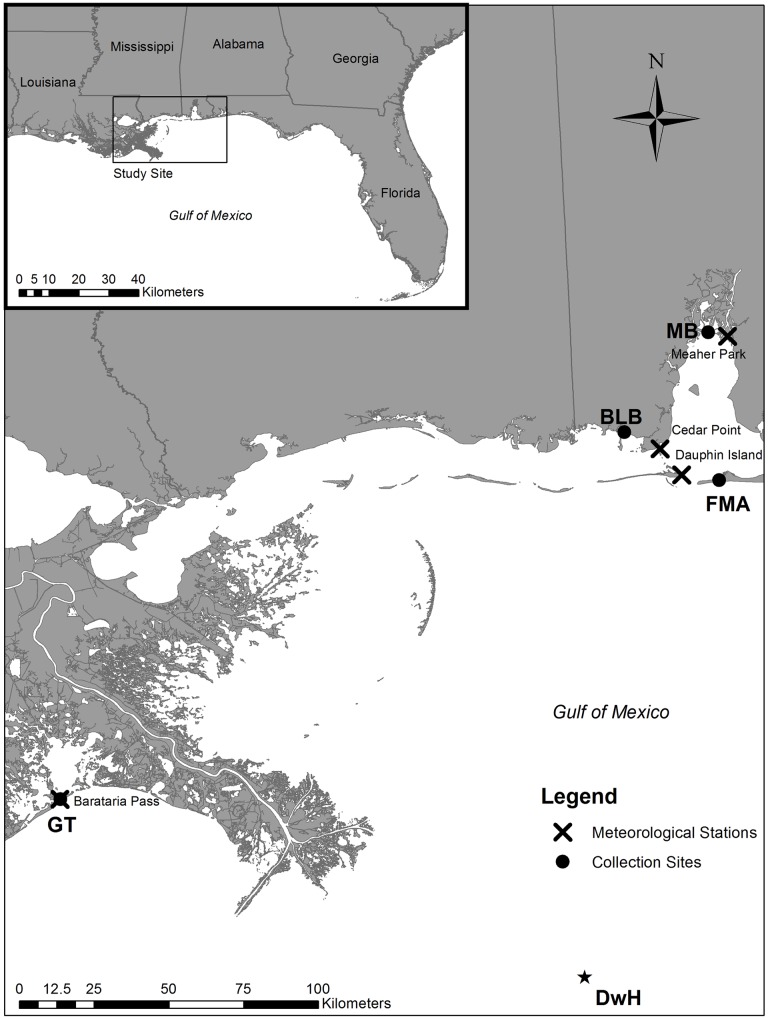
Map of study sites in the northern Gulf of Mexico.General (inset) and specific location of Gulf killifish (Fundulus grandis) collection sites in Grande Terre [GT], LA; Bayou La Batre, AL [BLB]; Mobile Bay, AL [MB]; and Fort Morgan, AL [FMA], throughout 2010 (May-August). The point labeled DwH indicates the site of the Deepwater Horizon explosion on April 20, 2010. The closest meteorological stations to the fish collection sites are marked by Xs.